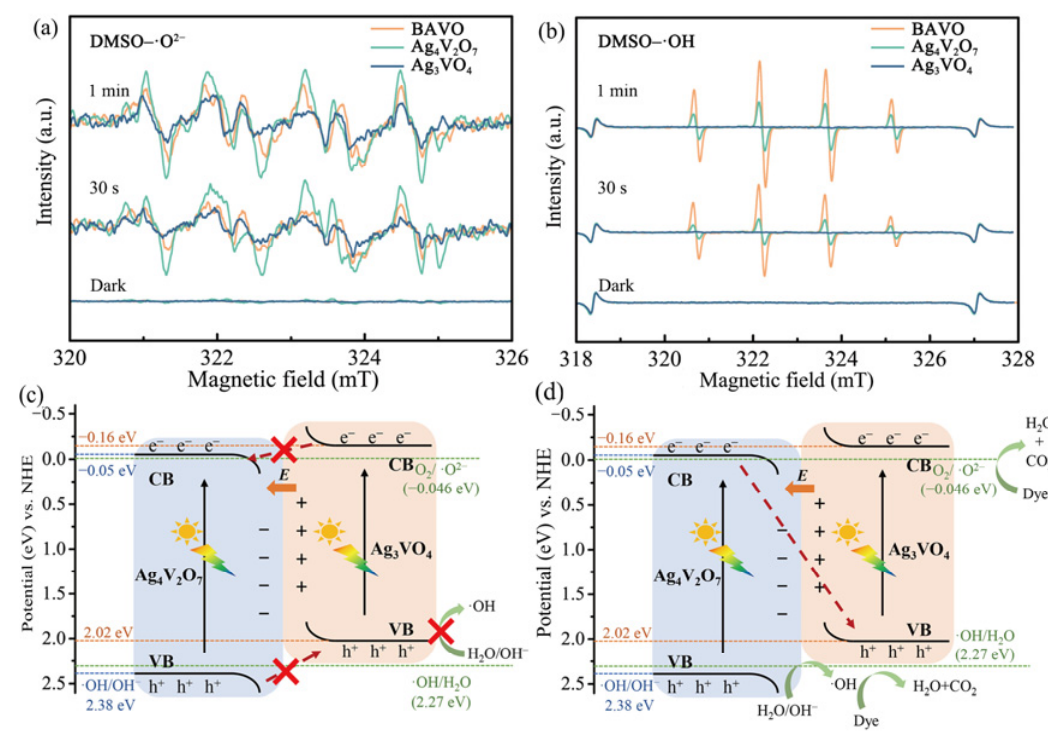
Fig. 8 EPR spectra of (a) ·O 2 − and (b) ·OH for Ag 3 VO 4 , Ag 4 V 2 O 7 , and BAVO photocatalysts; schematic diagrams of (c) Type-II and (d) Z-scheme mechanism for Ag 3 VO 4 /Ag 4 V 2 O 7